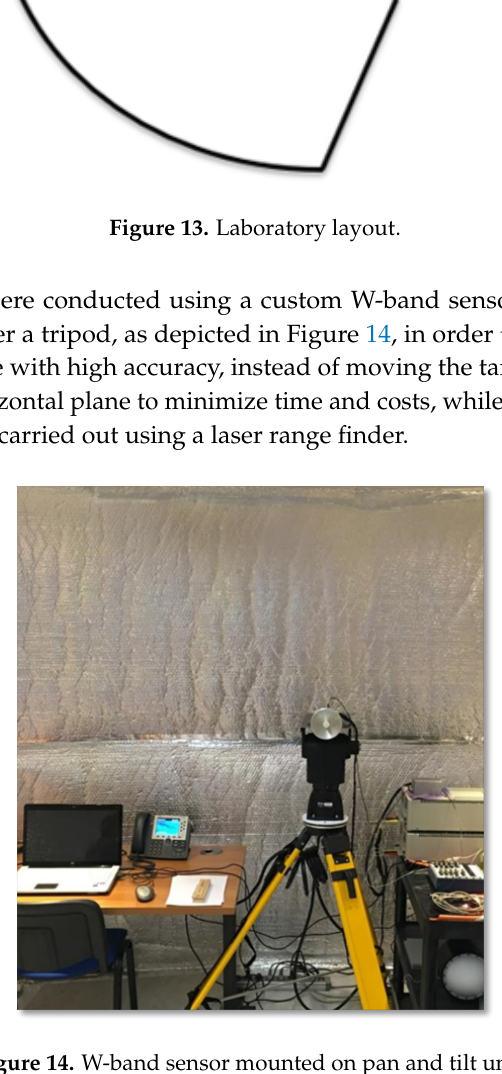
Figure 14. W-band sensor mounted on pan and tilt